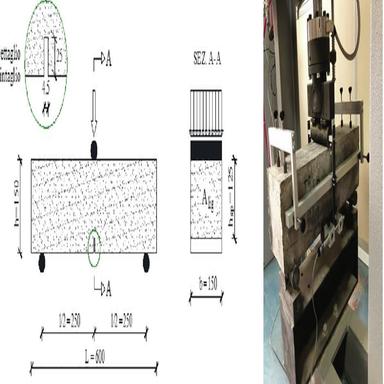
Details of experimental set-up of the three-points bending test.